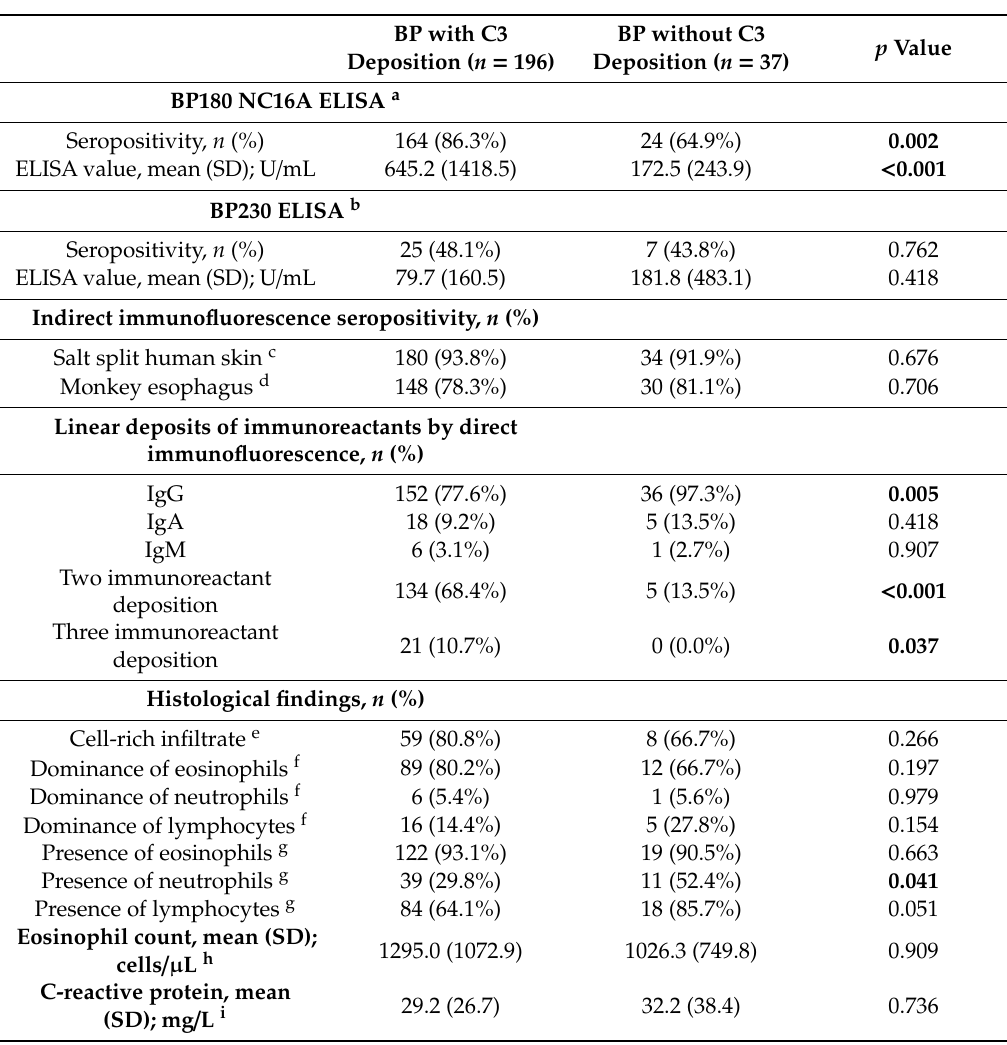
Table 2. Immunological characteristics and laboratory findings of BP patients with C3 deposition by DIF as compared to BP patients without C3